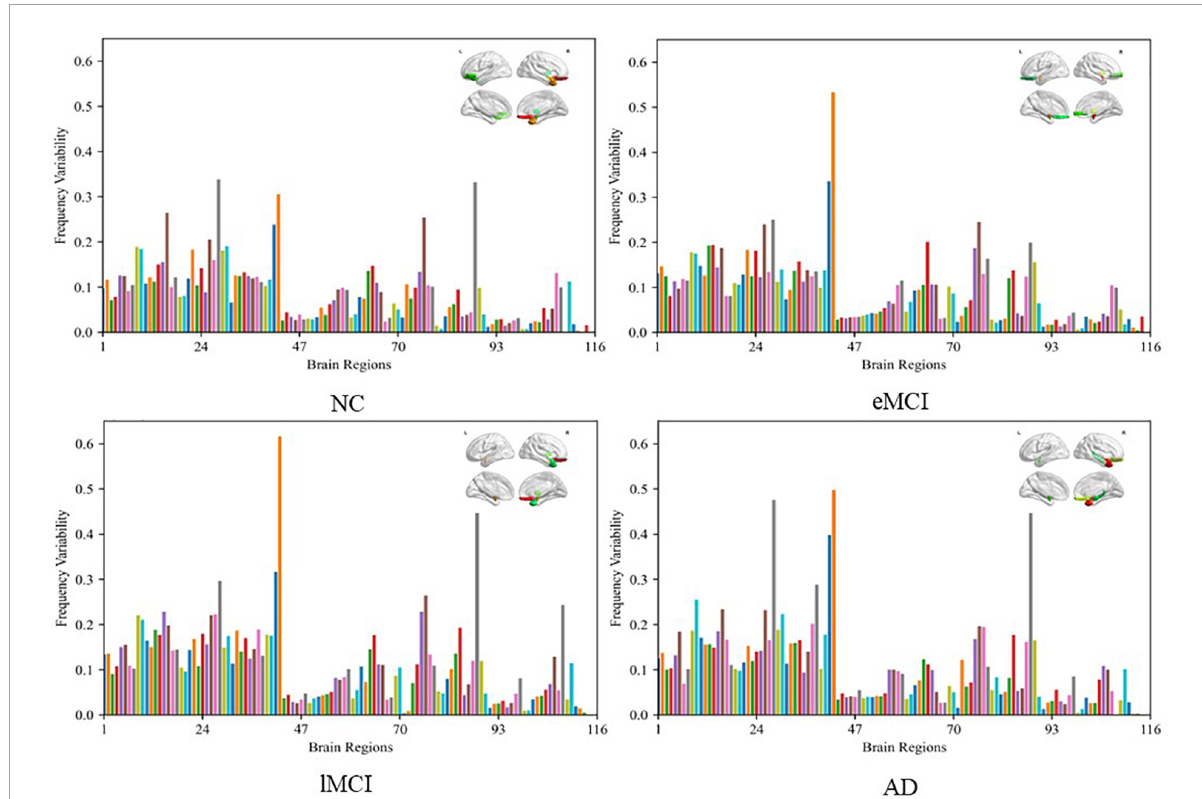
FIGURE7 Frequency variability of all regions of interests (ROIs) in four categories (i.e., NC, eMCI, lMCI, and AD). The top right in every figure represents the ROI with the highest frequency variability (FV).